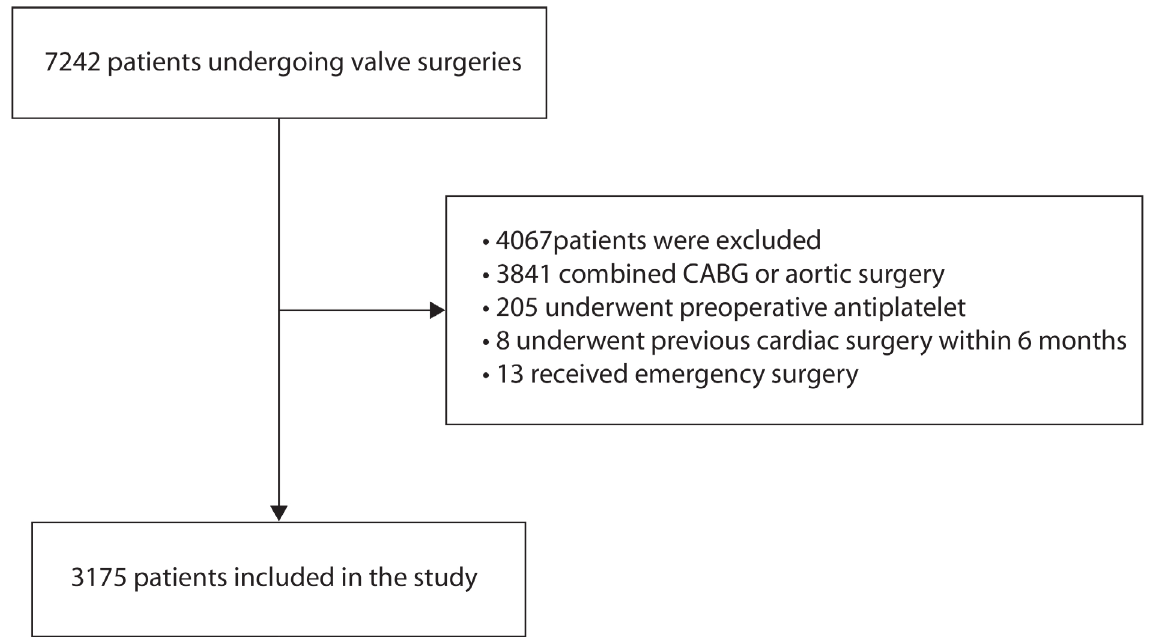
Fig. 1 - Flow diagram of patients’ inclusion and exclusion. CABG=coronary artery bypass